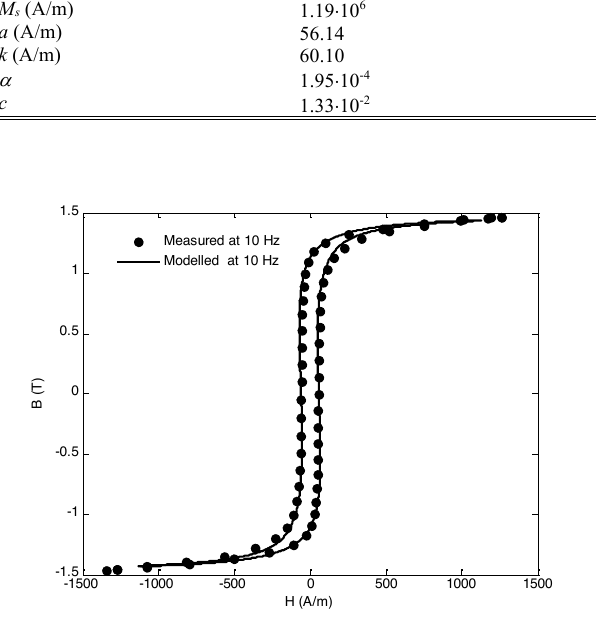
FIGURE 1. Modelled and measured hysteresis